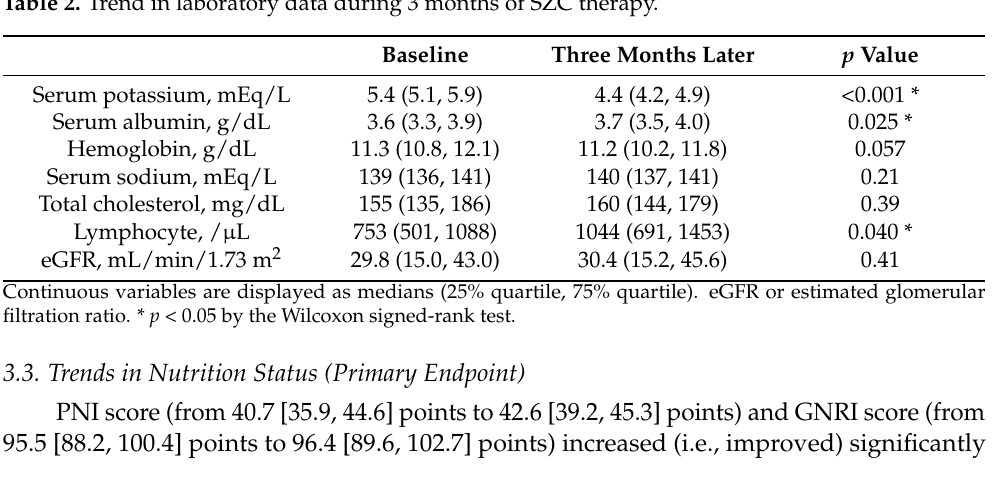
Table 2. Trend in laboratory data during 3 months of SZC